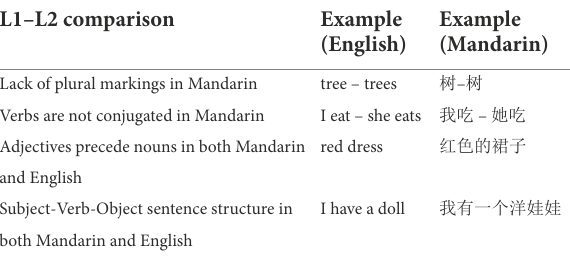
TABLE 2 Teachers’ comments on essential metalinguistic information that compares students’ L1 (English) and L2 (Mandarin). L1–L2 comparison Example Example (English)